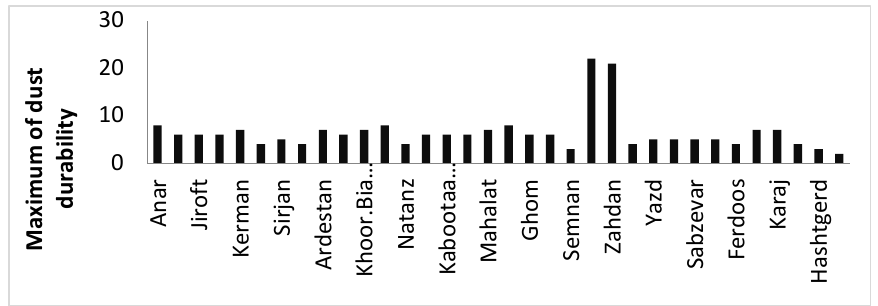
Figure 7. Diagram of maximum DDD, 1999–2018, in the study area. There is a big difference between the DDD values of Zahdan and Zabol stations and the other stations in the study area. Although stations in the central deserts of Iran such as Khor, Biabank, Yazd, and Semnan, also have favorable climatic and edaphic conditions for wind erosion, the Zahdan and Zabol stations are the most affected by the 120-day winds of Sistan, known as the monsoon winds, that blow continuously over prolonged periods. Furthermore, regarding the average annual-maximum dust day duration in the study area, Zabol station with an average of 15 days and Zahdan station with an average of 14.3 days had the highest values over the study period. On the other hand, Hashtgerd and Semnan stations with 0.98 and 1.25 days, respectively, had the lowest values in the area (Figure 8).